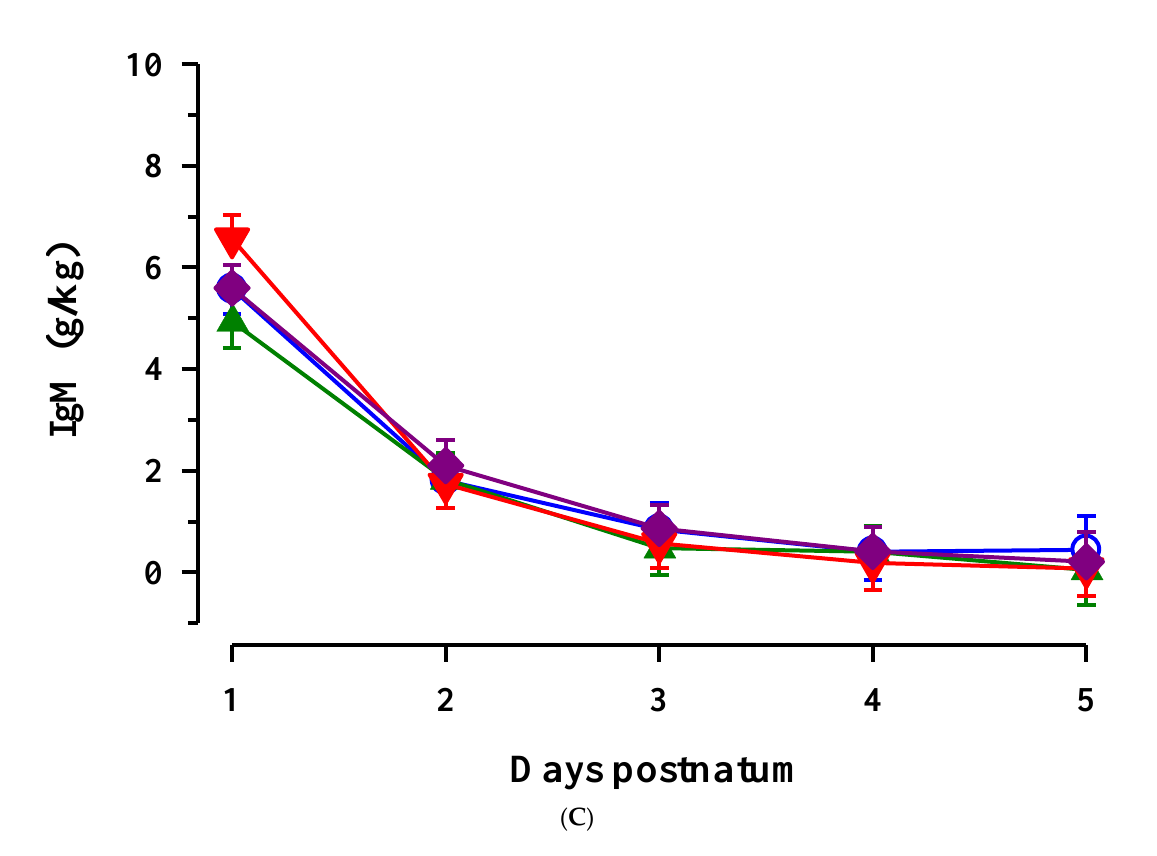
Figure 1. Immunoglobulin (Ig) G 1 ( A ), IgG 2 ( B ) and IgM ( C ) concentration in colostrum and transition milk of cows receiving fatty acid supplementation ( ○ control, CON n = 9; ▲ EFA, essential fatty acids, n = 9; ▼ , CLA, conjugated linoleic acid, n = 9; ♦ , EFA + CLA, n = 11) and time after calving. Day 1 correspond to the day of birth. ab Different superscripts mark significant differences between groups at similar time points ( p < 0.05).